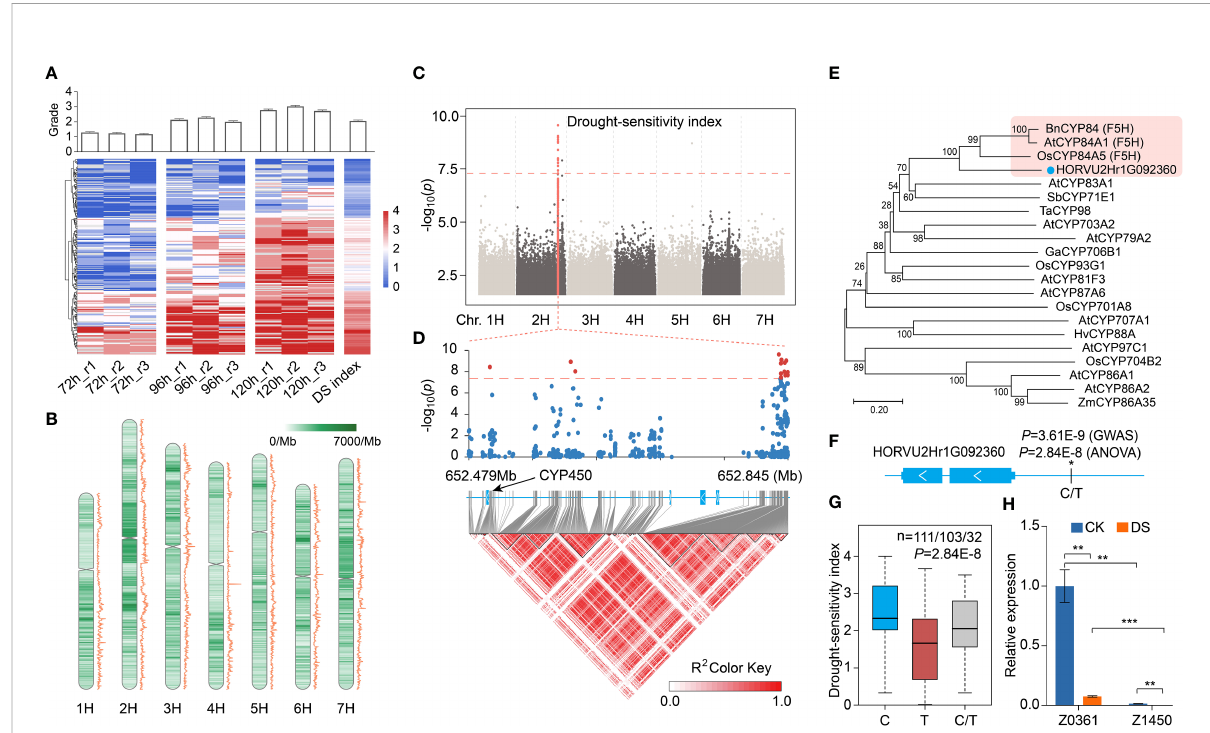
FIGURE 1 Drought resistance grading and functional variation of signi fi cant association sites of DSI-based GWAS. (A) The heat map shows the drought resistance grades of 246 qingke under drought stress for 72 hours, 96 hours and 120 hours (three biological replicates in each group). Blue indicates low wilting rate, and red indicates high wilting rate. The average grades of each variety in all groups are calculated as drought-sensitivity index (DSI). The upper bar graph shows the average grades of each group. (B) SNP distribution (heat map) and p value (line chart) along chromosome per 1Mb. (C) Manhattan plot displaying the GWAS result for the DSI. Orange dots indicate SNP in signi fi cance association loci. Gene model of HORVU2Hr1G092360 , which is located 333 kb from the lead SNP (2H: 652834792), is shown. (D) A representation of the genes and pairwise R 2 value among polymorphic sites in signi fi cant associated loci of DSI, where the darkness of the color of each box corresponds to the R 2 value according to the legend. The scatter plot above represents the P -value of GWAS of each SNP in this area, red and blue indicate signi fi cant and non-signi fi cant SNPS, respectively. (E) An unrooted phylogenetic tree of CYP450 genes was constructed as described in Methods. Bootstrap values (based on 1000 replications) are indicated at each node (bar: 0.2 amino acid substitutions per site). (F) Gene model of HORVU2Hr1G092360, a fi lled blue box represents the exon. The “ * ” represents the SNP 2H:652503665 upstream of the gene, and the P-value in GWAS and ANOVA analysis of this SNP is also marked. (G) Boxplot showing the correlation between 2H:652503665 upstream of HORVU2Hr1G092360 and DSI. C, T and C/T represent reference, alternate and heterozygous base. (H) Relative expression of HORVU2Hr1G092360 in drought-resistant qingke (Z0361) and drought-sensitive qingke (Z1450) under CK and DS conditions, HvADP-RF gene as internal control. Data are shown as the mean ± SEM, n = 3. Student ’ s t-test, P -value< 0.01, marked with “ ** ” . P -value< 0.001, marked with “ *** ”